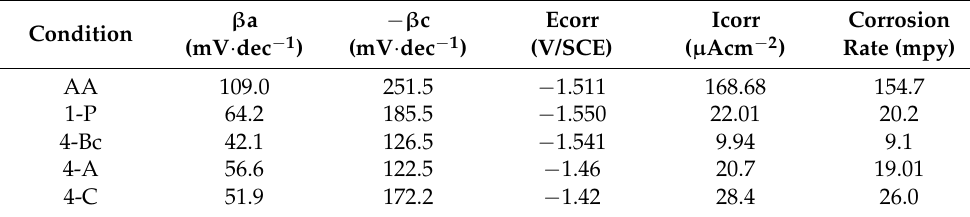
Table 2. Electrochemical parameters obtained from potentiodynamic polarization curves of the AA condition and ECAP-processed ZK30 Mg